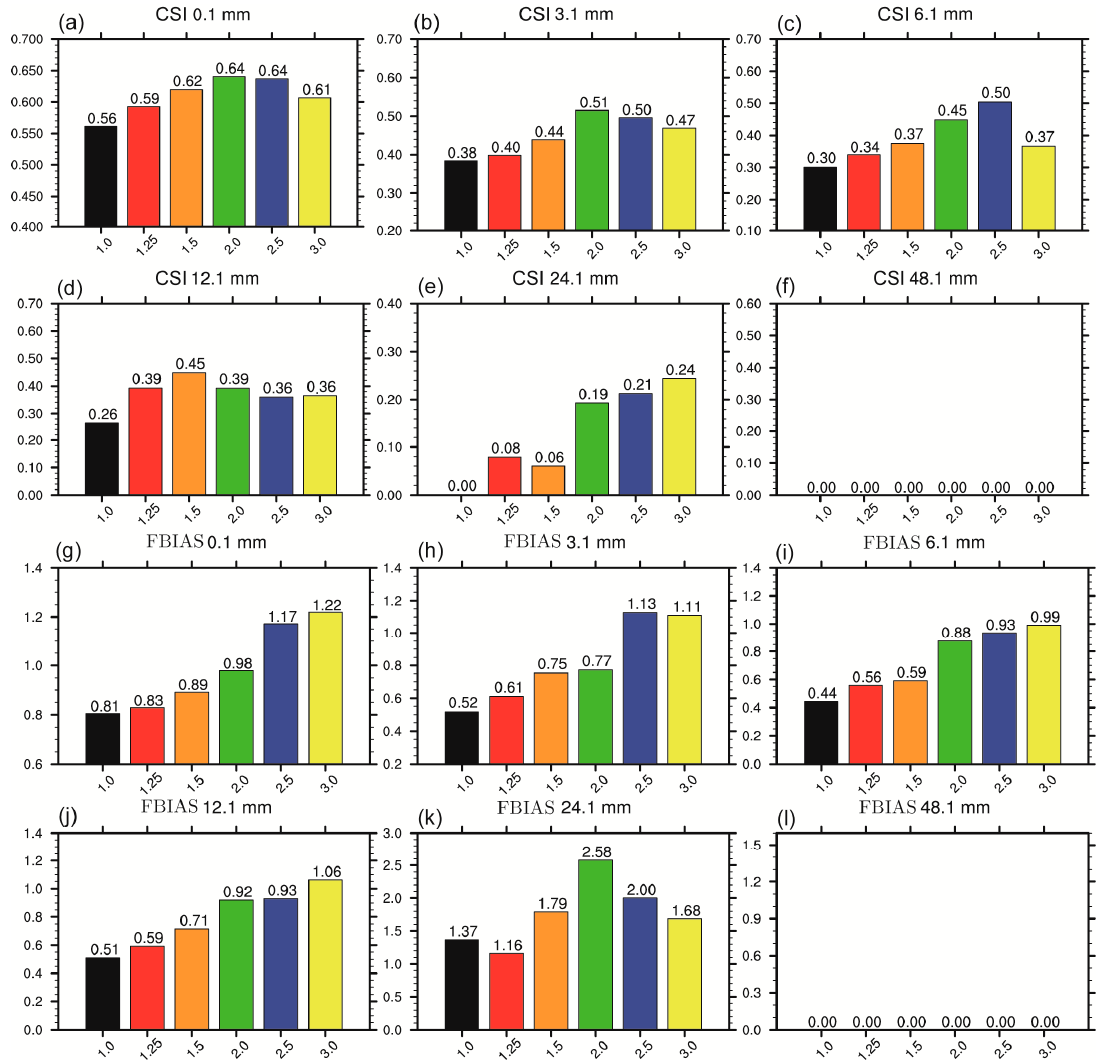
Figure 10. The critical success index (CSI) and frequency bias (FBIAS) values of 24-h accumulative precipitation of the WRF simulations under different soil moisture initial conditions at each precipitation magnitude: ( a , g ) 0.1 mm; ( b , h ) 3.1 mm; ( c , i ) 6.1 mm; ( d , j ) 12.1 mm; ( e , k ) 24.1 mm; and ( f , l ) 48.1 mm. The 1.0, 1.25, 1.5, 2.0, 2.5 and 3.0 multiples of NCEP GFS soil moisture are represented as black, red, orange, green, blue and yellow columns, respectively.